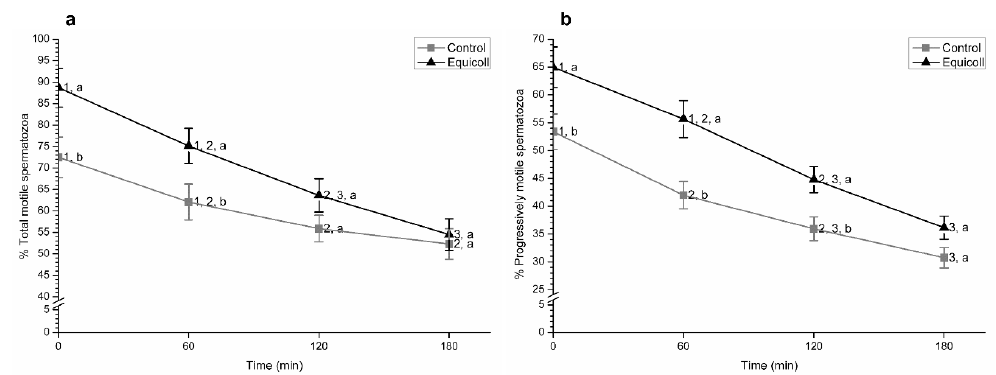
Figure 5. Proportions of ( a ) total and ( b ) progressively motile spermatozoa in control (non-selected samples) and SLC-selected samples (Equicoll). Different superscript letters (a, b) indicate significant differences ( p ≤ 0.05) between the control and SLC-selected samples, and different superscript numbers (1–3) mean significant ( p ≤ 0.05) differences between time points within the control or samples selected with Equicoll. Data are shown as mean ± SEM for 10 separate experiments. SLC: single layer centrifugation. Table 1. Sperm kinematic parameters (as mean ± SEM) in control (non-selected samples) and SLC- selected samples (Equicoll).